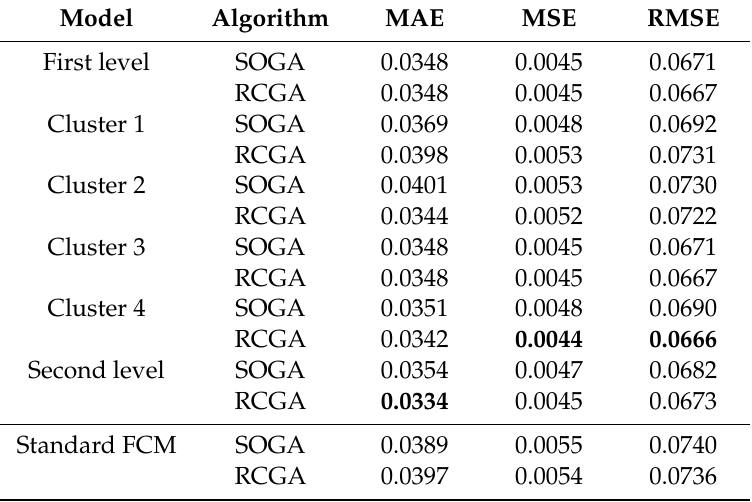
Table 3. Best results for the nested fuzzy cognitive map and standard fuzzy cognitive